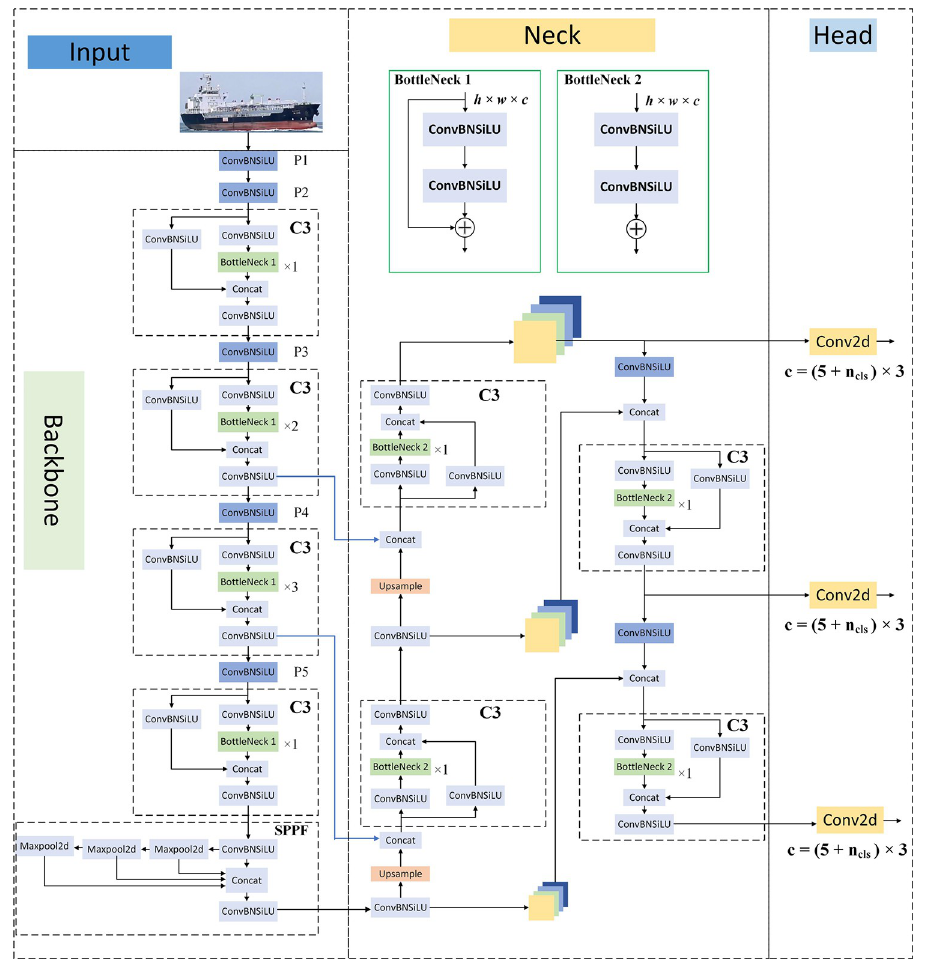
Fig 1. YOLOv5s network